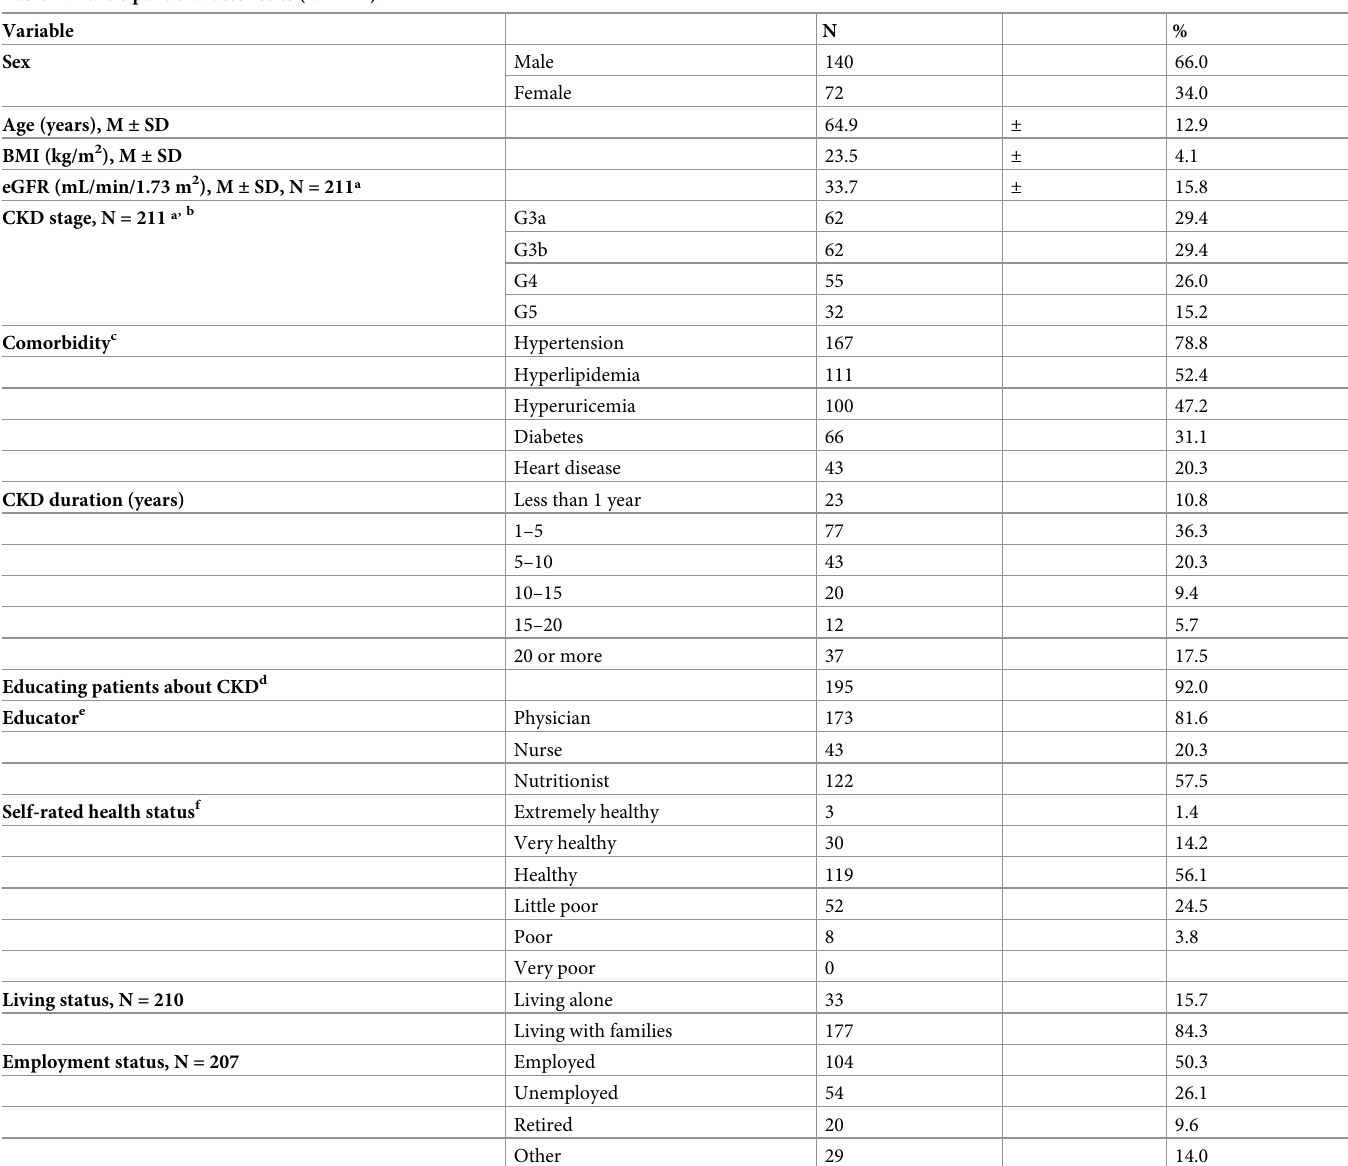
Table 1. Participant characteristics (N =